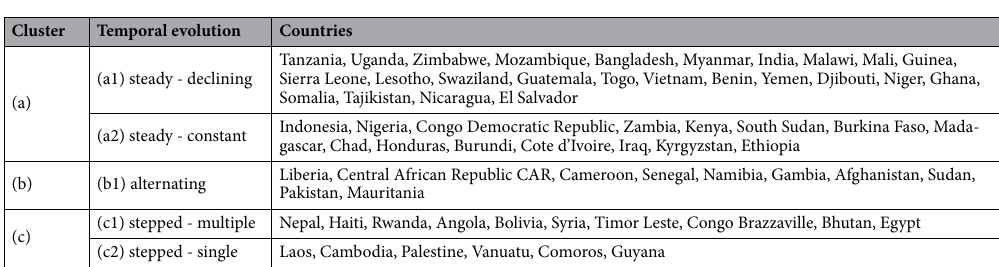
Table 3. Clusters of temporal trajectories of the monthly number of buildings added, changed and deleted in OSM per country between 2012/01/01 and 2020/05/20. The groups are defined by a hierarchical clustering approach based on a distance matrix derived from dynamic time warping time series similarity analysis. This table lists all countries with medium and low human development index (SHDI<0.7).